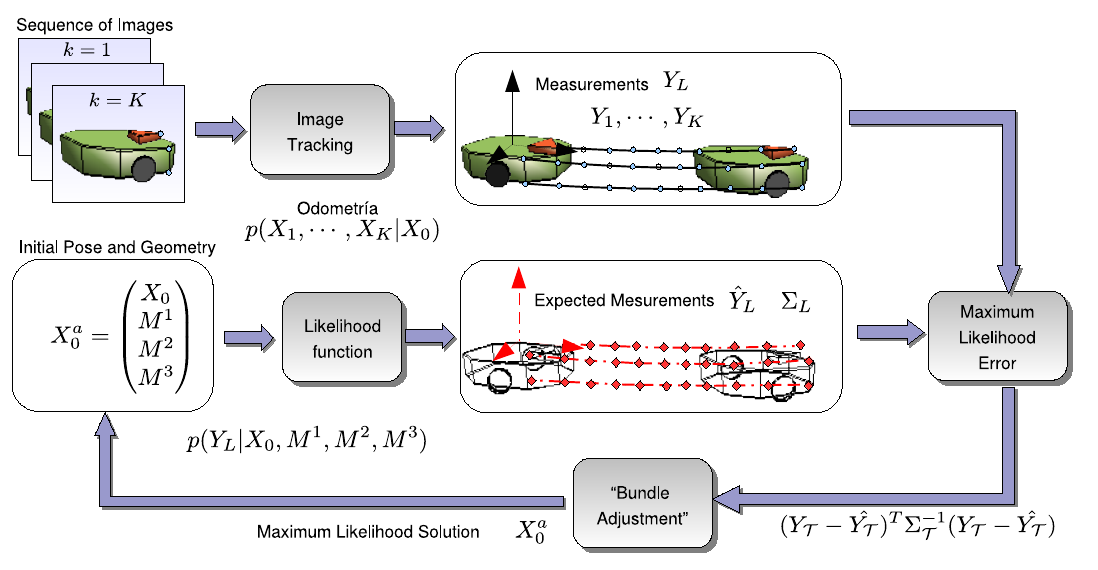
Maximum likelihood initialization by means of reducing the residual of the expected measurements (red diamonds) and the measured image trajectories (blue